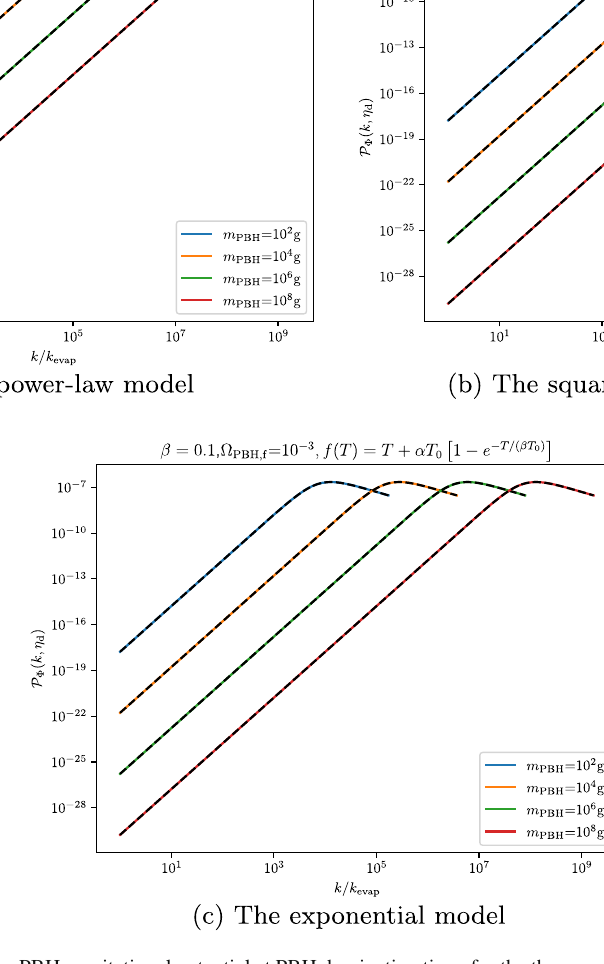
Fig. 2 The power spectrum of the PBH gravitational potential at PBH domination time, for the three mono-parametric f ( T ) models, by choosing different values of the PBH mass m PBH . In all graphs we have used β = 0 . 1 and (cid:13) PBH , f = 10 − 3 . The dashed curves correspond to the GR